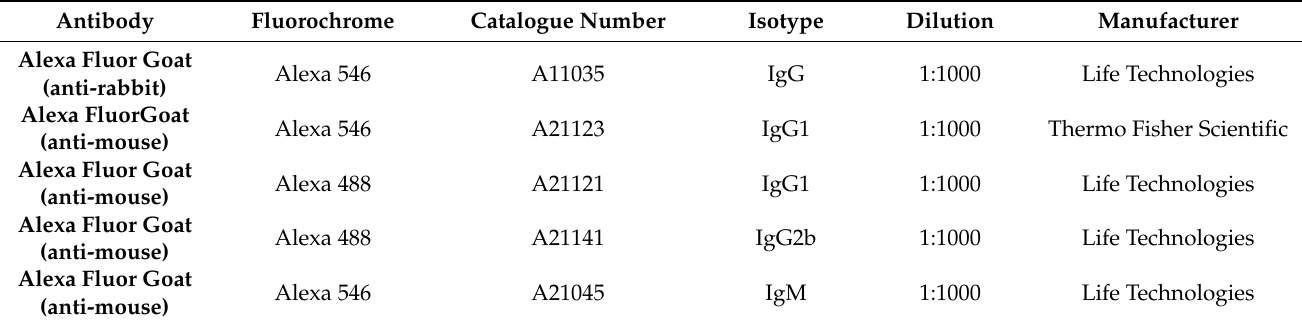
Table 3. Secondary antibodies used in immunocytochemistry